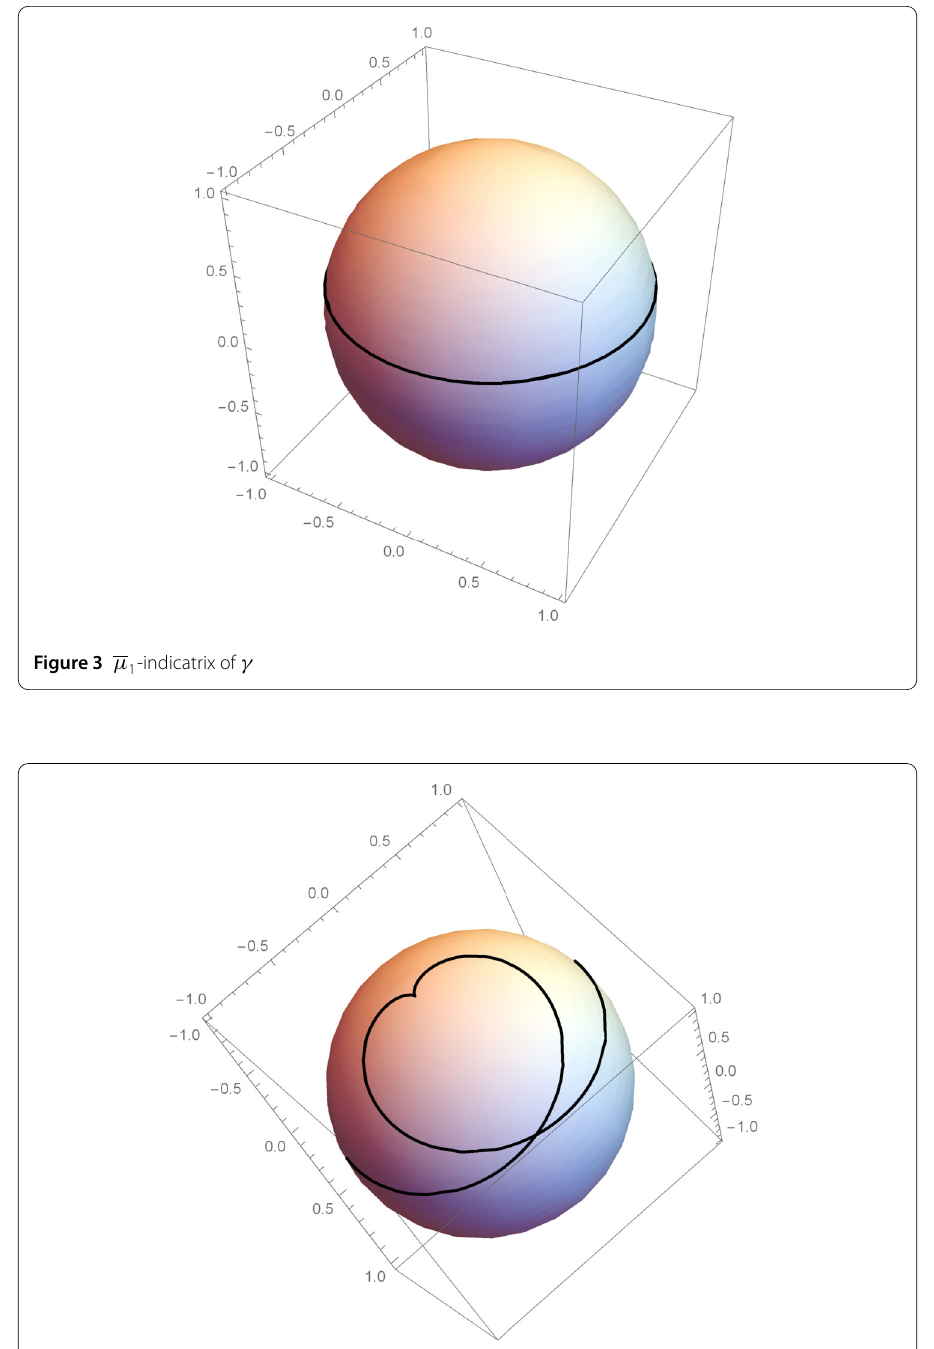
√ for the framed curve ( γ , μ 2 6 -indicatrix of γ , and the μ 1